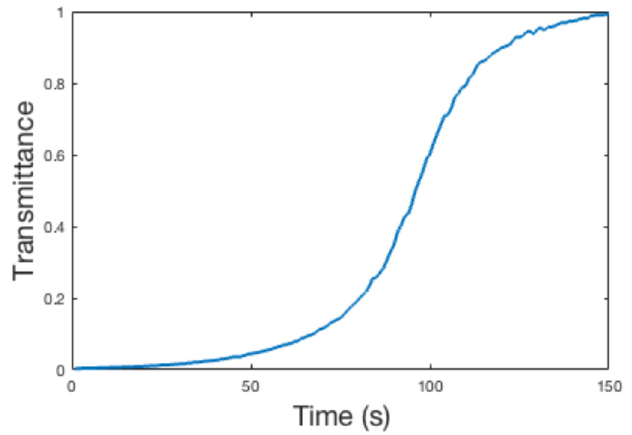
Figure 2. A cycle of fog dissipation inside the fog chamber.